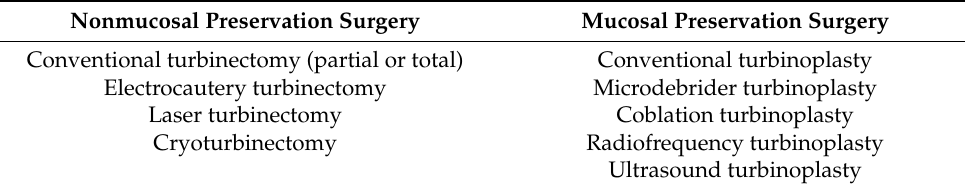
Table 1. Type of surgical technique for turbinate